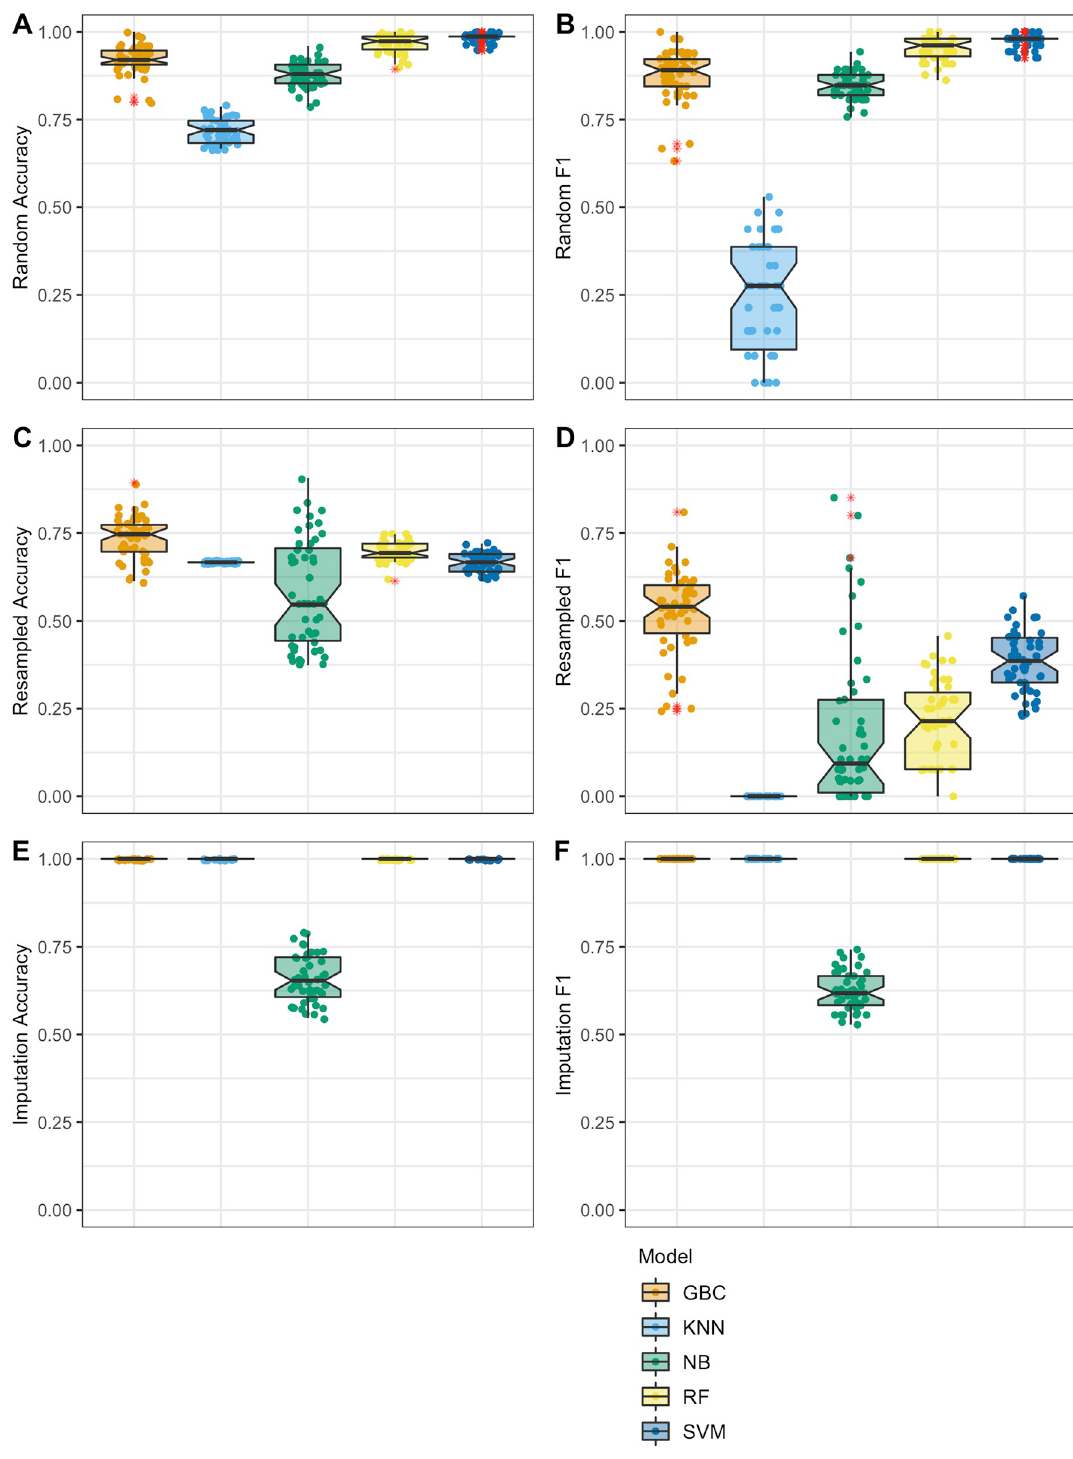
Fig 2. Classification accuracy using copy number data. Fabricated data was mixed with real data and given to four machine learning models for classification. Data shown represents 50 trials for 50 different fabricated dataset mixes. Features in this dataset are the copy number values for each sample. Outliers are shown as red asterisks; these same outliers are shown also as normally colored points in jittered-point overlay. A . Results for data fabricated with the random method, mean classification accuracy: RF 97% (+/- 2.5%), SVM 98% (+/- 1.5%), GBC 92% (+/- 4.2%), NB 88% (+/- 3.5%), KNN 72% (+/- 3.4%). B . Results for data fabricated with the random